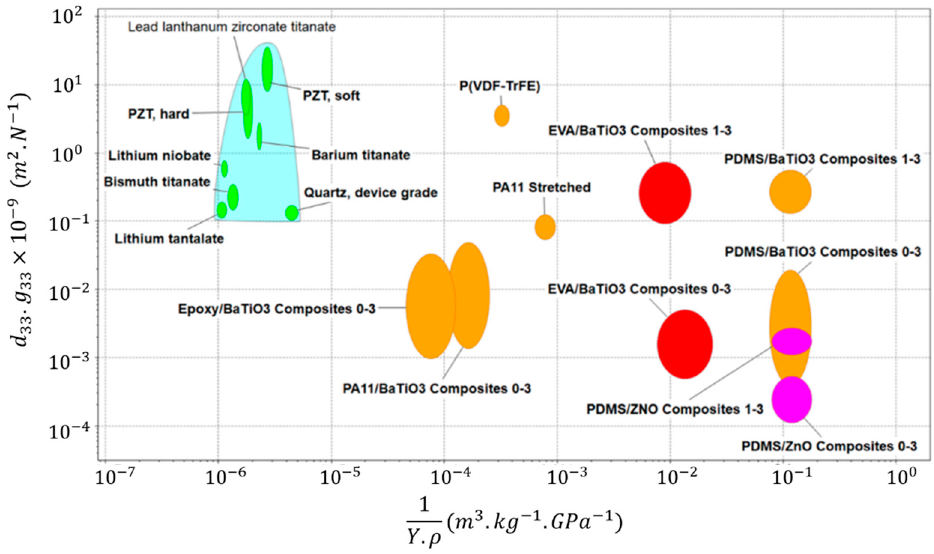
Figure 12. Ashby graph of d 33 . g 33 as a function of 1/( Y . ρ ) for various piezoelectric